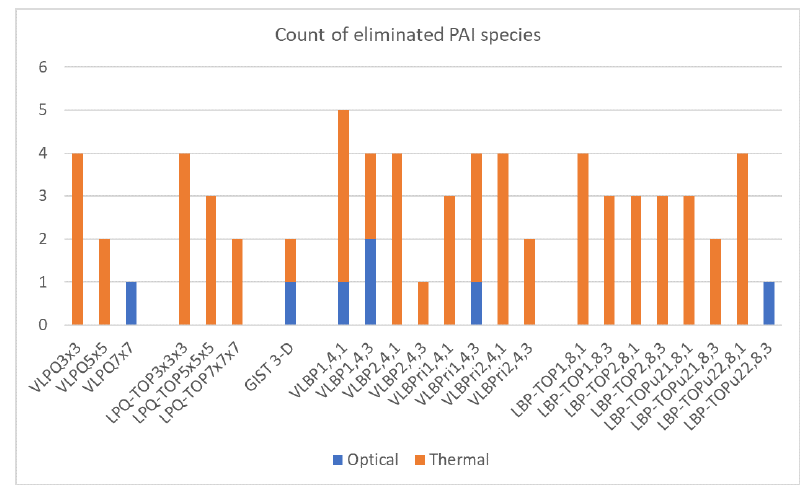
Figure 13. PAD mechanisms capability of eliminating PAI species.